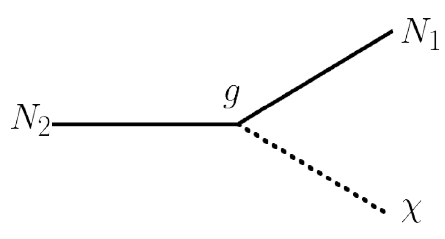
Figure 2 . The Feynman diagram for Majorogenesis in the scenario